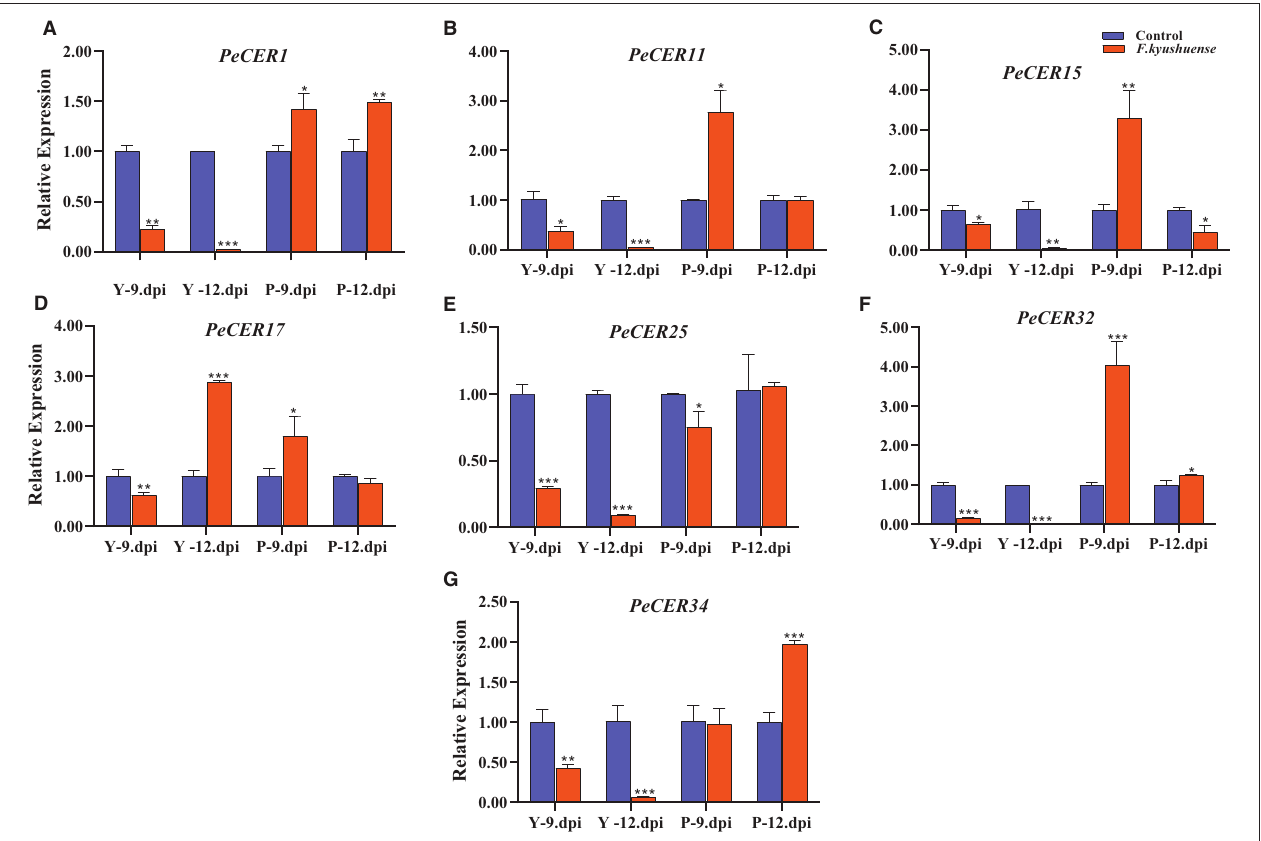
FIGURE 13 | qRT-PCR expression profiles of PeCER genes (A–G) in peel tissues of yellow and purple passion fruit cultivars under F. kyushuense biotic stress and control conditions. Relative gene expression levels were calculated using 2 − 11 ct . Vertical bars represents means ± SD ( n = 3). *, **, and *** show significance at p ≤ 0.05, p ≤ 0.01, and p ≤ 0.001, respectively, under control and biotic stress conditions according to Students t -test. Y, yellow passion fruit; P, purple passion fruit; dpi, days post inoculation.